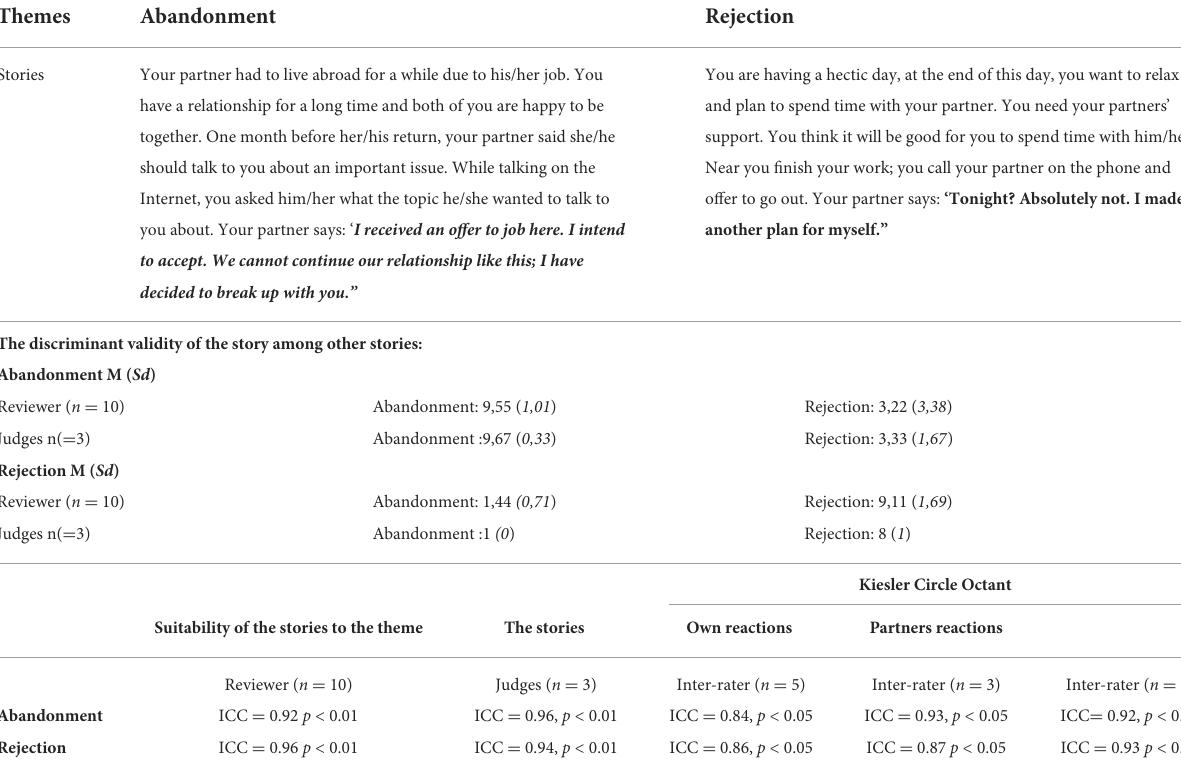
TABLE A1 Abandonment and rejection stories, validity and